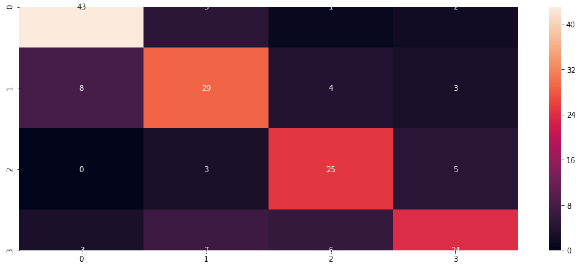
Figure 9. Confusion matrix for emotion recognition system 8 represents the confusion matrix as obtained for the gen- der recognition system and Fig 9 represents the confusion matrix for emotion recognition